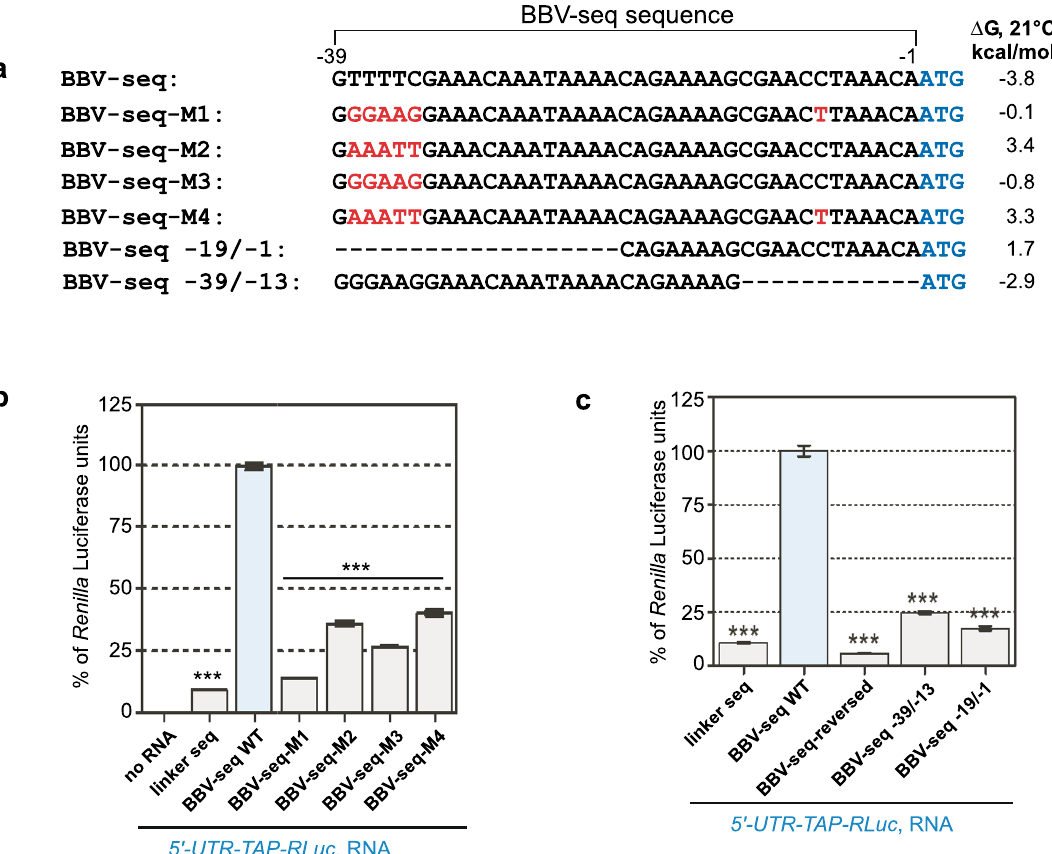
Figure 2. Nucleotide substitutions within BBV-seq result in inhibition of translation in cell-free reactions. ( a ) Sequence alignments of wild-type and mutant BBV-seq sequences relative to the ATG start codon for the respective constructs are shown here for comparison. Gibbs energies (∆G) at 21 °C calculated for each BBV-seq variant are shown on the right. ( b , c ) RNAs containing indicated 5 ′ -UTR upstream of TAP- RLuc reporter were used in cell-free translation reactions as described in Fig. 1d. Production of the protein reporter was analyzed using a Renilla luciferase assay and is presented as bar graphs. Data represented as % of Renilla luciferase units derived from the reaction containing BBV-seq-WT-TAP-RLuc mRNA. Error bars represent standard error of the mean (SEM) of three individual experiments. “***” denotes P -value <